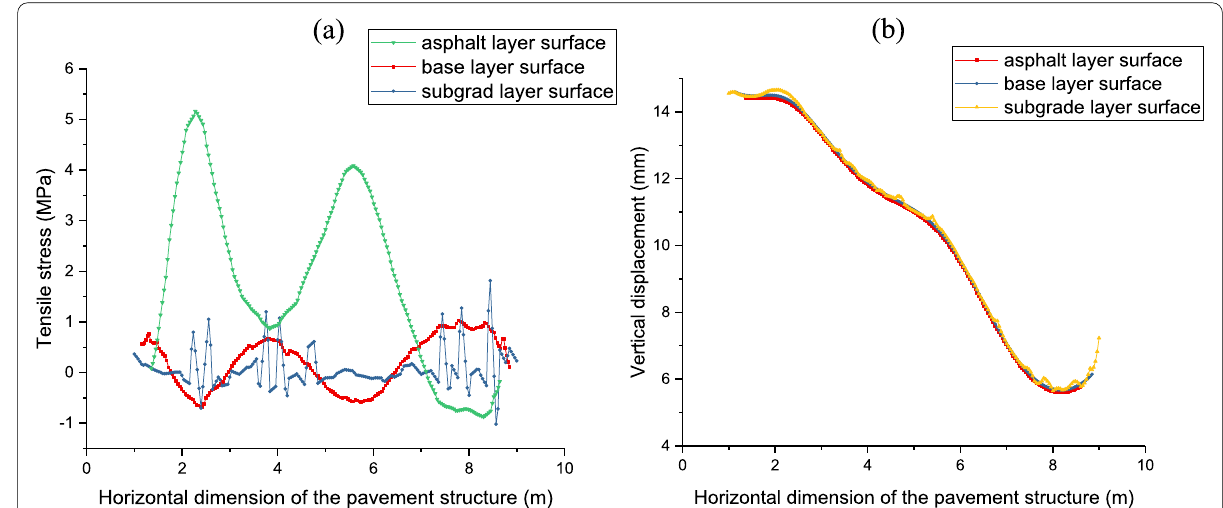
Fig. 9 a The tensile stress and b the vertical displacement in the pavement structure on March 1st, 2017 at Anchorage,